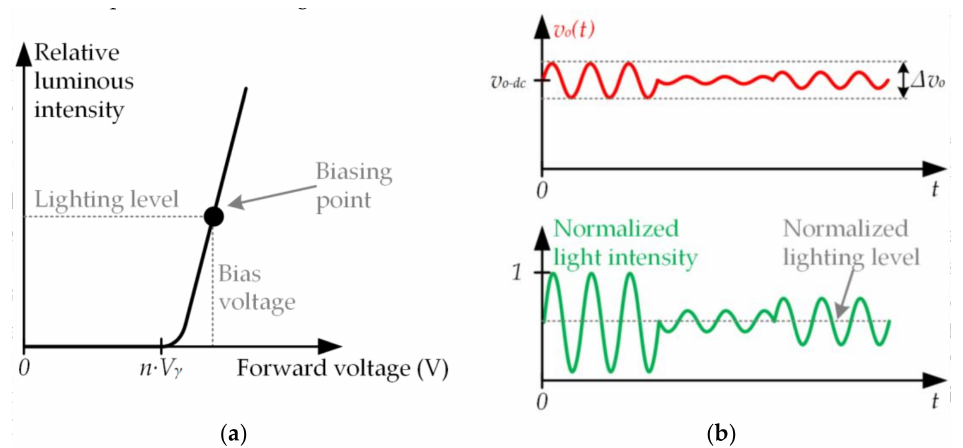
Figure 4. ( a ) Relationship between the light intensity emitted by a string of n LEDs and the applied voltage; ( b ) Example of the involved voltage and normalized light intensity waveforms when a pass-band signal is reproduced.